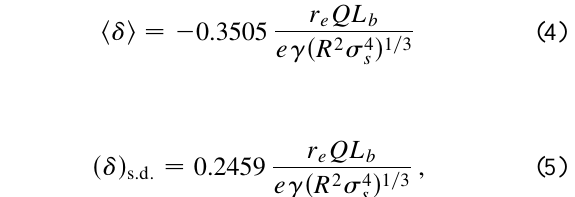
a Gaussian input beam with 100 000 particles, charge of 1 nC, and an rms bunch length of 50 m m. The bending radius was 1.5 m. This matches the parameters used in the example in Saldin et al .